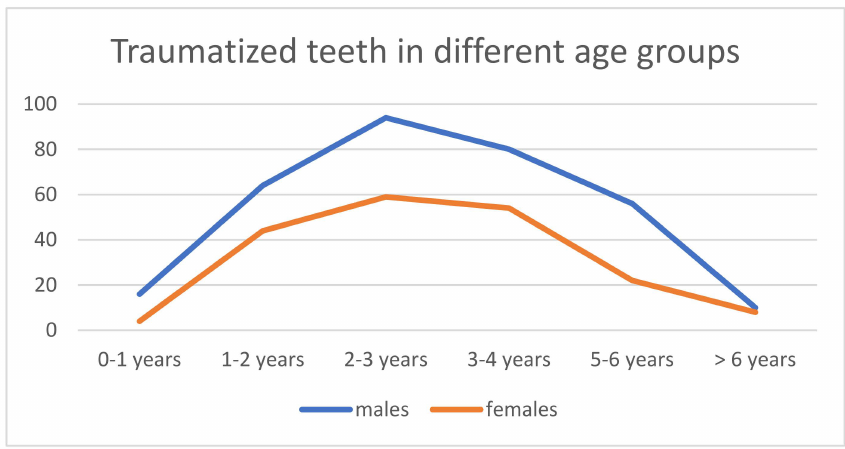
Figure 1. Association between age and DT.